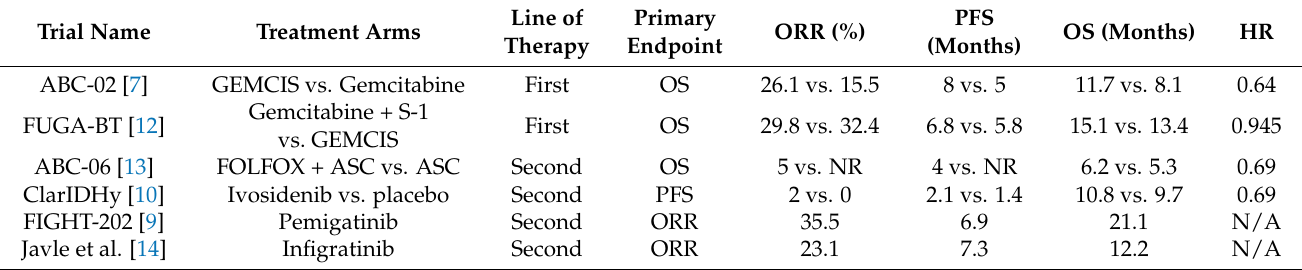
Table 1. Key findings of clinical trials for the approved systemic therapies in advanced